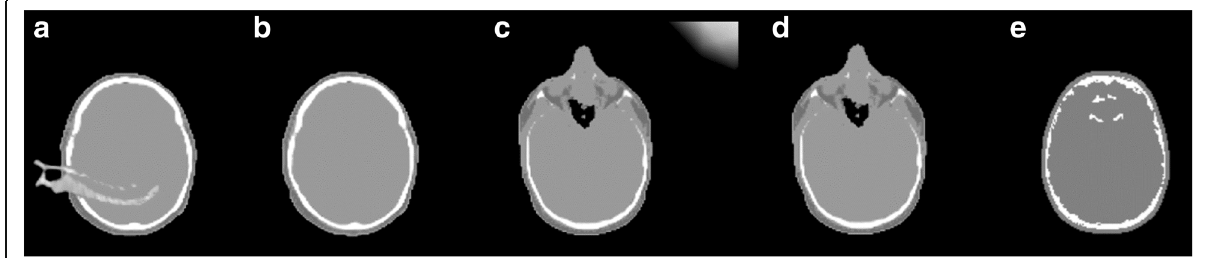
Fig. 1 Typical bone artifacts found in attenuation maps from PET/MRI. a Dixon Bone attenuation map with large infiltrative bone segment. Attenuation maps like this were only included in the study if the patient had a second acquisition yielding b an artifact-free attenuation map. c Dixon Bone attenuation map with artifact in the upper right corner, which could be d manually removed. e UTE attenuation map with smaller bone segments inside the brain nearby the anterior ventricles. These were not